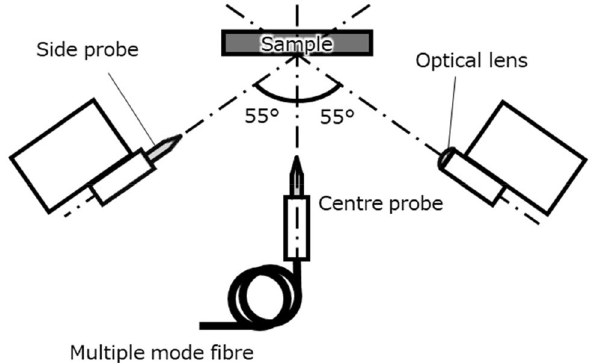
Figure 2. Schematic image of sample and probe units. The centre probe (C-probe) is connected to a multiple- mode optical fibre. Both side attachments (side probe (S-probe) or classical lens) is set at an angle of 55° to the